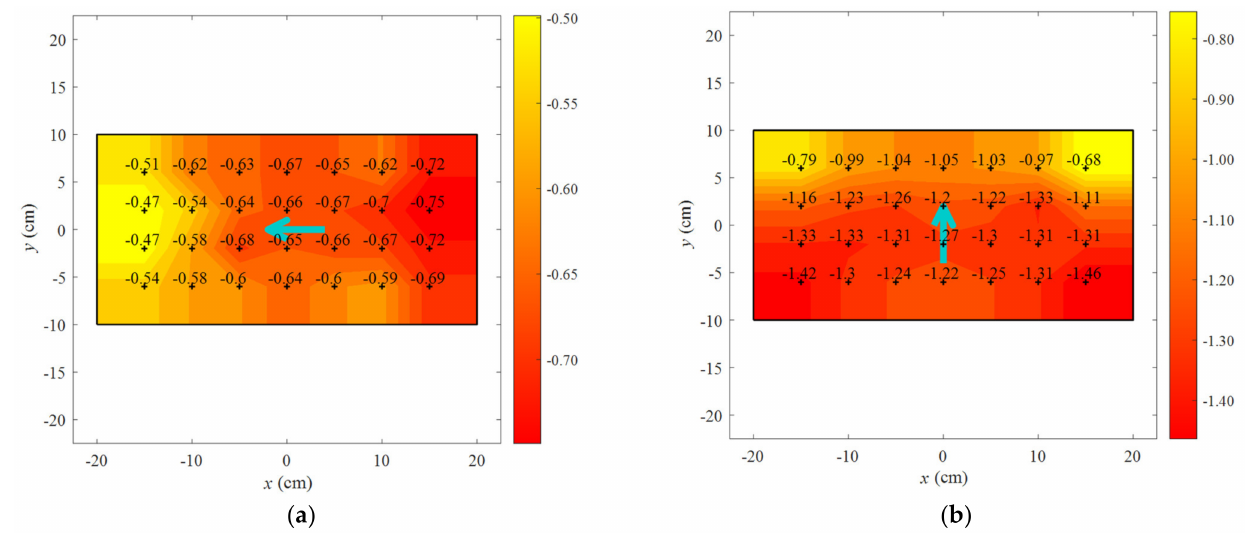
Figure 2. Example of mean pressure coefficients maps for RLC at ( a ) 0 ◦ and ( b ) 90 ◦